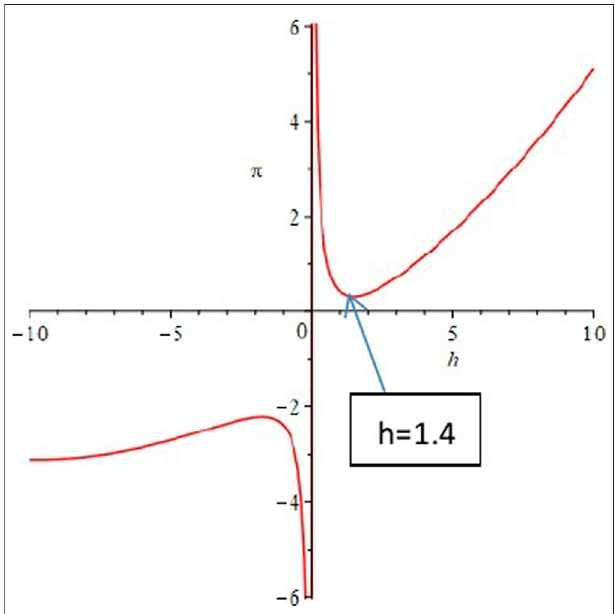
FIGURE 2 | The relationship between enterprise E 1 income π 1 and h .